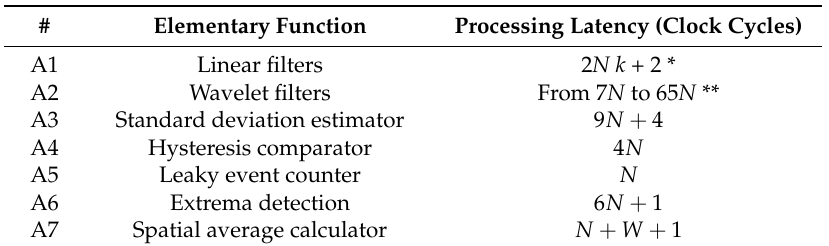
Table 1. List of the elementary real-time processing